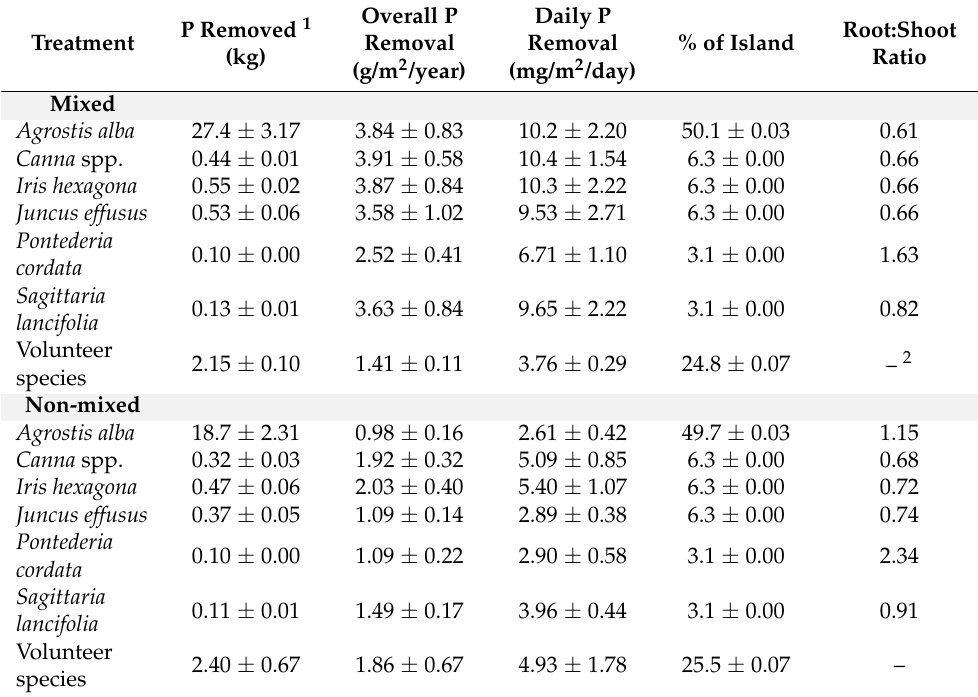
Table 3. Total phosphorus (P) removed at harvest in April 2019, yearly and daily P removal rate per m 2 of floating treatment wetland, percent island biomass by treatment and plant species, and root:shoot